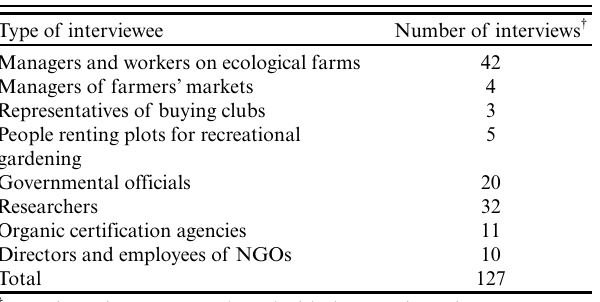
Table 2 . Number of interviews conducted with different types of